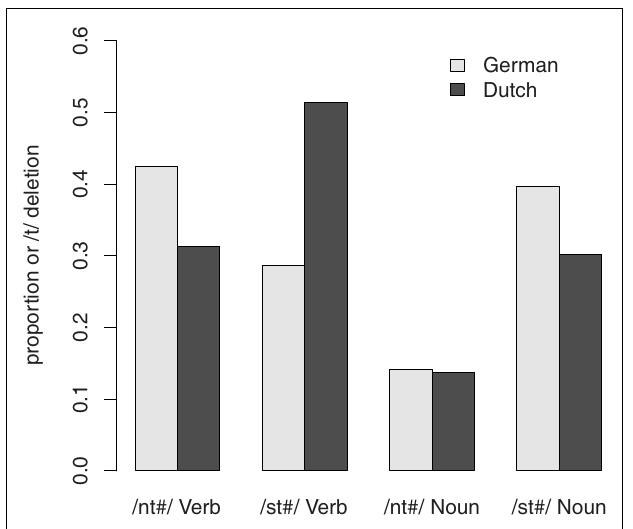
FIGURE 1 | Proportion of /t/-deletion in the same production tasks (Experiment 1) by Dutch and German speakers.